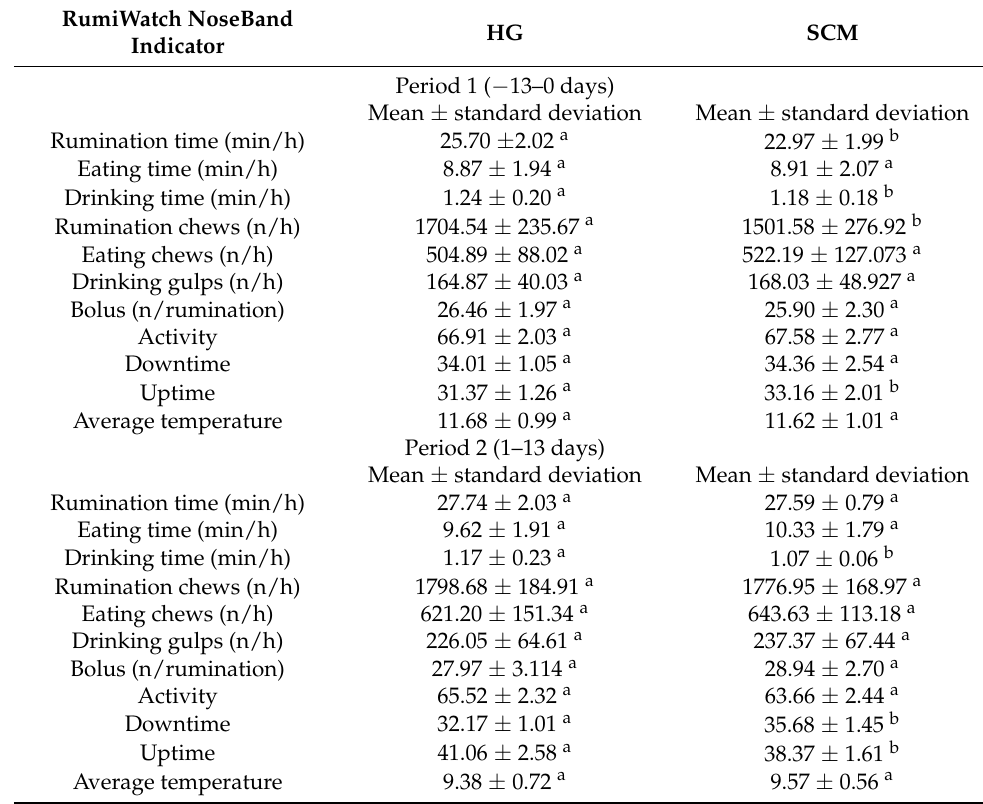
Table 2. Rumination behavior biomarkers registered with real-time sensors measured using the RumiWatch noseband sensor by groups of cows and experimental